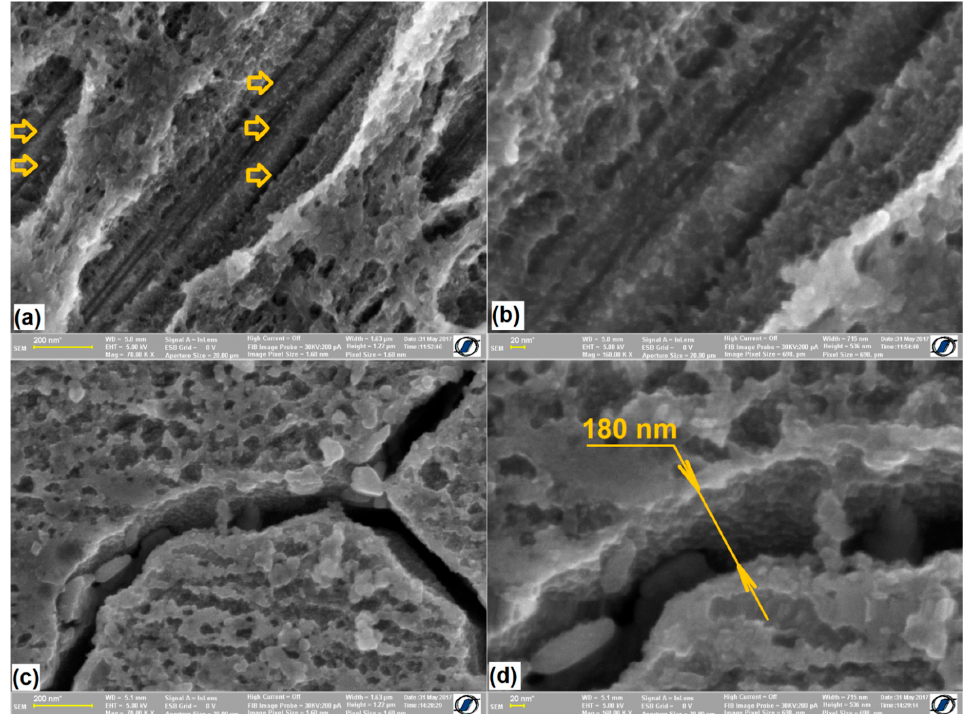
Figure 5. HR-SEM micrographs of specimens: ( a ) 0_MA_1100 , with a α′ -bcc martensite plate com- prising internal sub-bands marked by yellow arrows; ( b ) detail of three sub-bands disposed within the width of a single α (cid:48) -bcc martensite plate, at 0_MA_1100 ; ( c ) intergranular crack at 40_MA_1100 ; ( d ) detail of the intergranular crack width, at 40_MA_1100